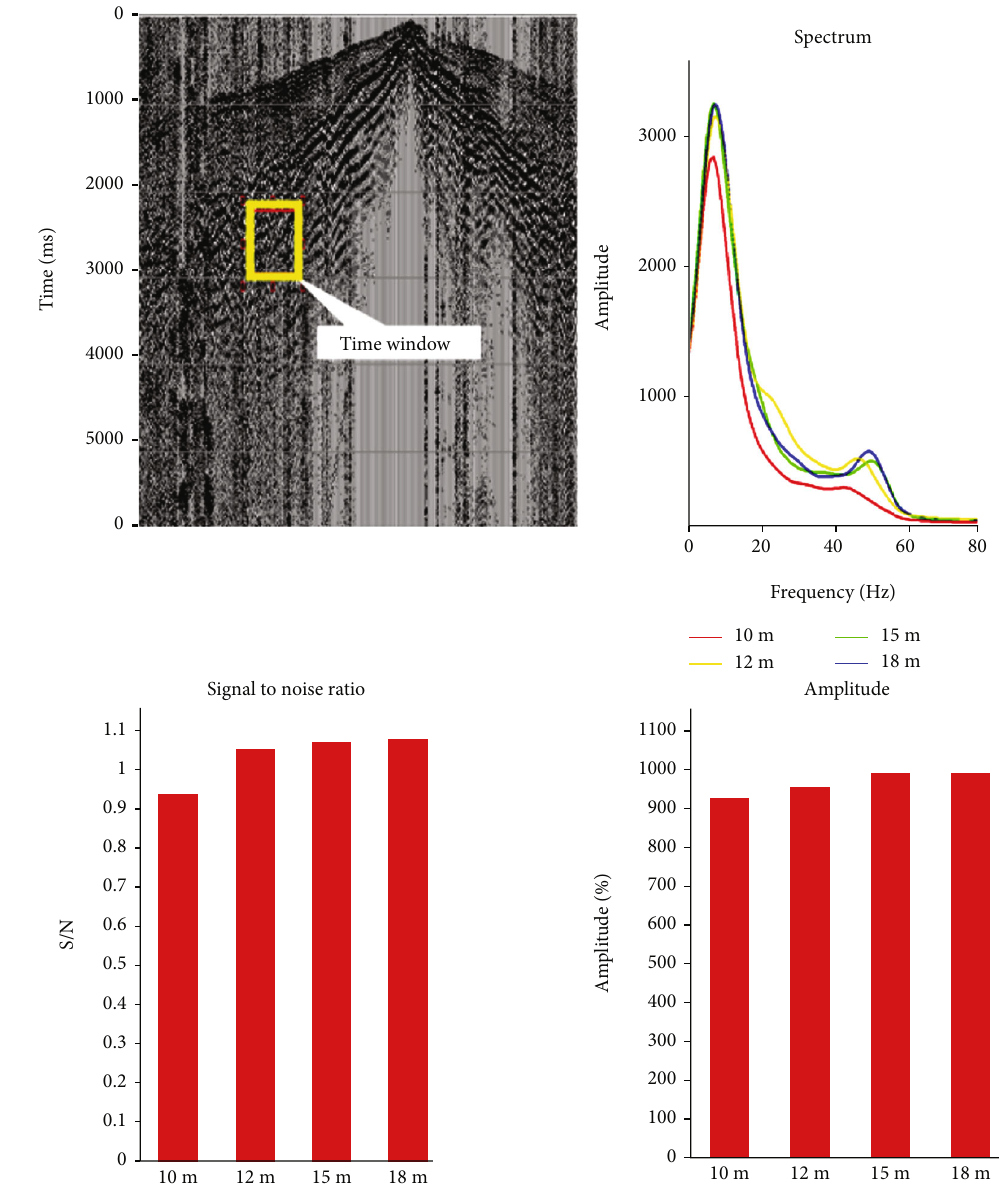
Figure 3: Quantitative analysis of charge